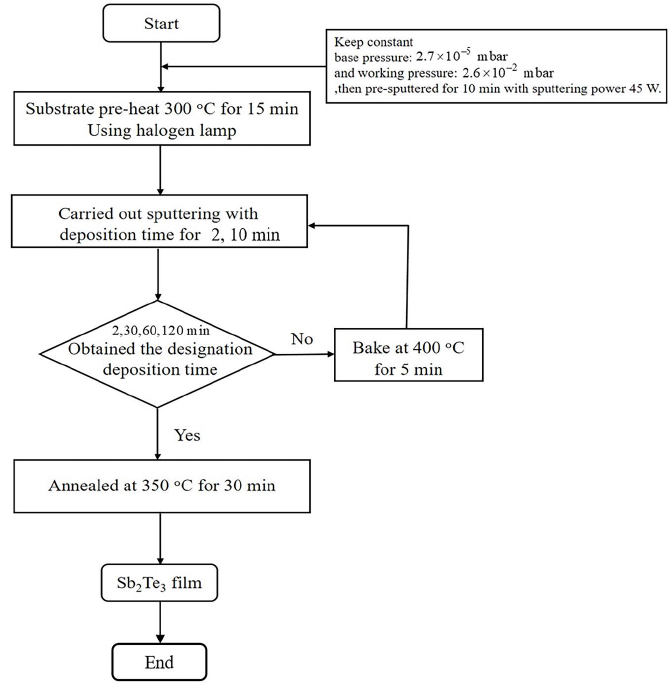
Figure 1. Schematic of the deposition method. 2.2. Materials Characterization Energy dispersive X-ray spectroscopy (EDX, Oxford Instruments X-Max 20, Singa- pore) was used to measure the average atomic percentage of Te on the surface over a large